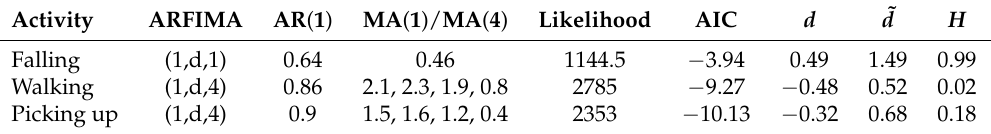
Figure 3. Original and first difference signals. Table 1. ARFIMA model for falls, walking and picking up